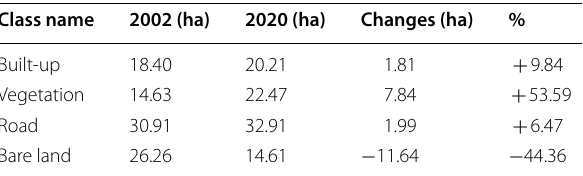
Table 7 LULC change for the Kebena riverside between